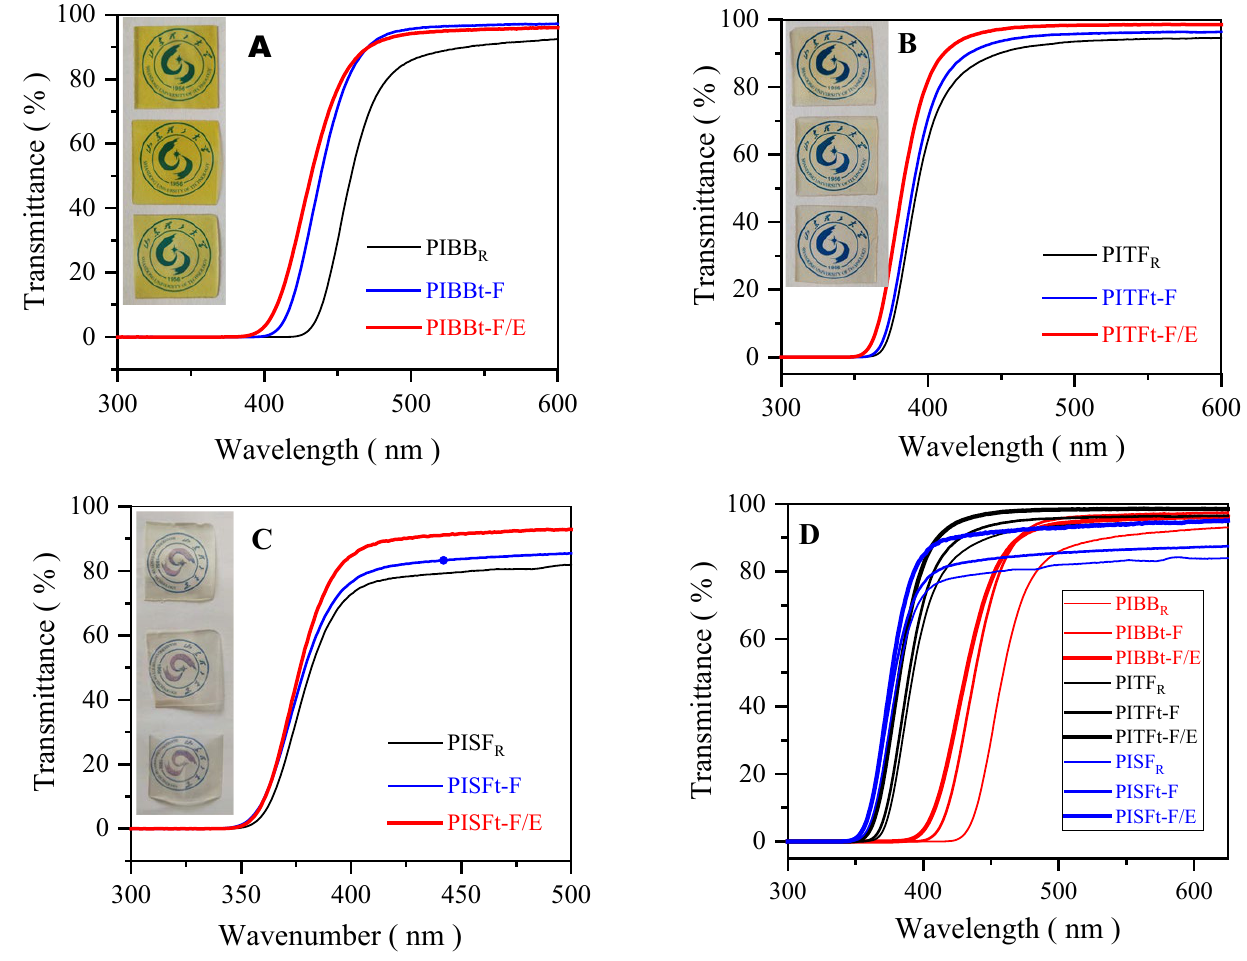
Figure 3. Digital photographs and UV-vis spectra comparison of the PIBBs ( A ), PITFs ( B ), PISFs ( C ) and UV-vis spectra comparison of PIBBs/PITFs/PISFs ( D ) after 250 °C treatment.